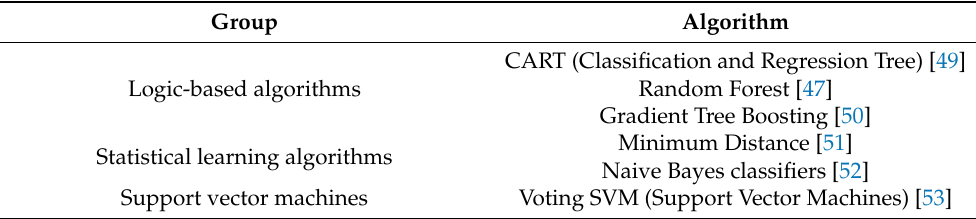
Table 3. Supervised machine learning for GEE in